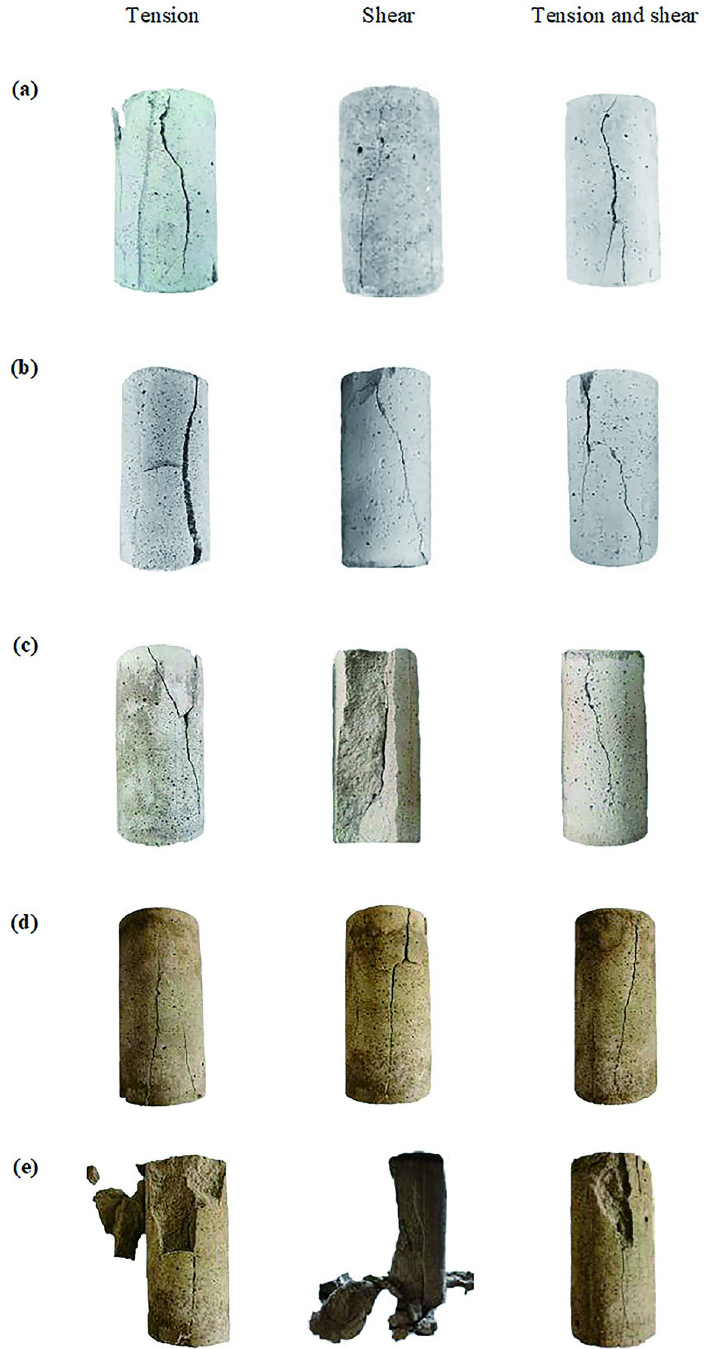
Fig 24. Failure mode of the test piece for rockburst-like material. (a) 20˚C. (b) 40˚C. (c) 60˚C. (d) 80˚C. (e) 100˚C. increased and the cracks in the specimen fully developed, continuously grew, and became interconnected to form macrocracks. The number of new cracks was high, number of frag- ments was increased, size of fragments was reduced, and the degree of fragmentation was intensified.